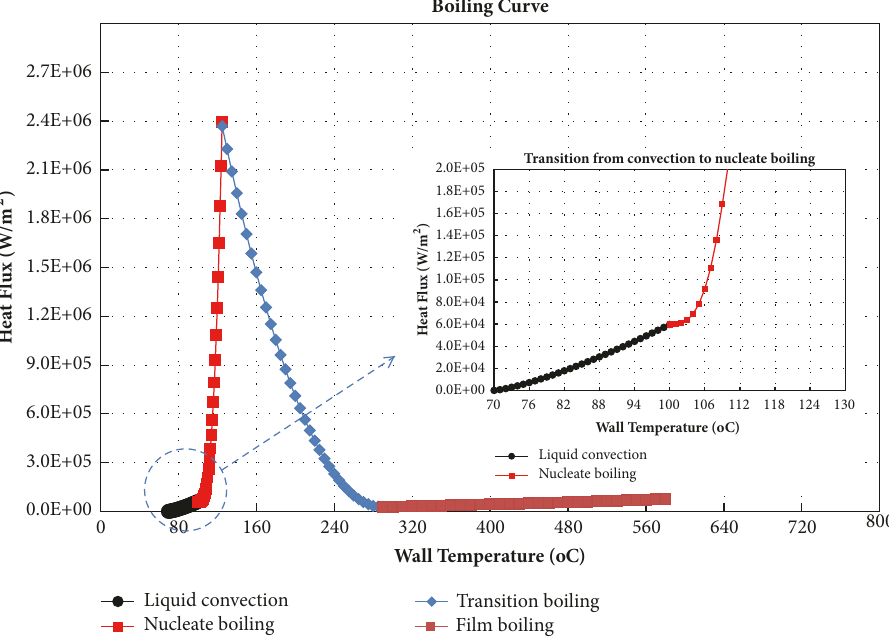
Figure 6: Boiling heat flux curve at the outer surface of Calandria tube.